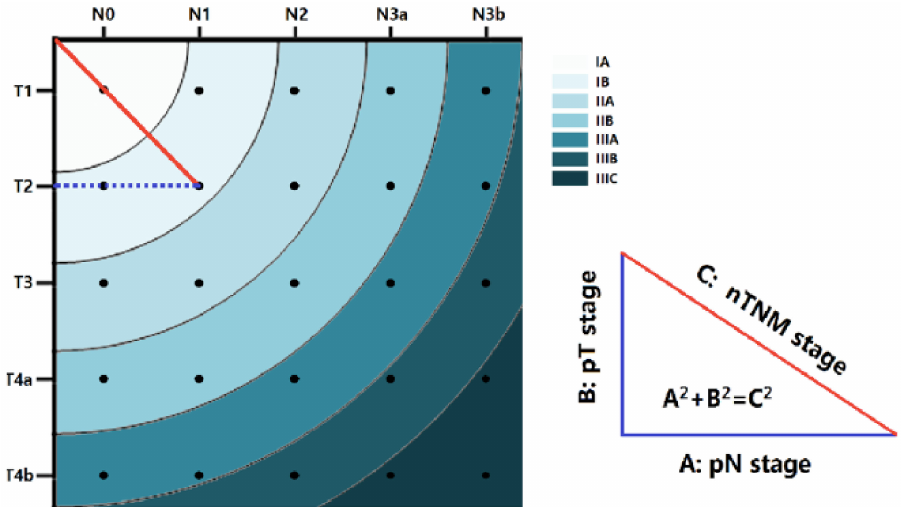
Figure 2. The ‘metro ticket’ prognostic tool for gastric cancer; the more we move further from the center, the worse the prognosis